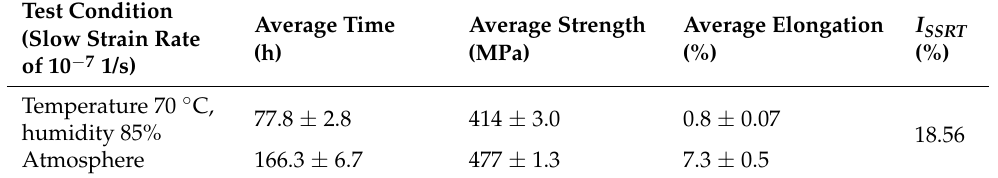
Figure 3. The stress-strain curves under different conditions.